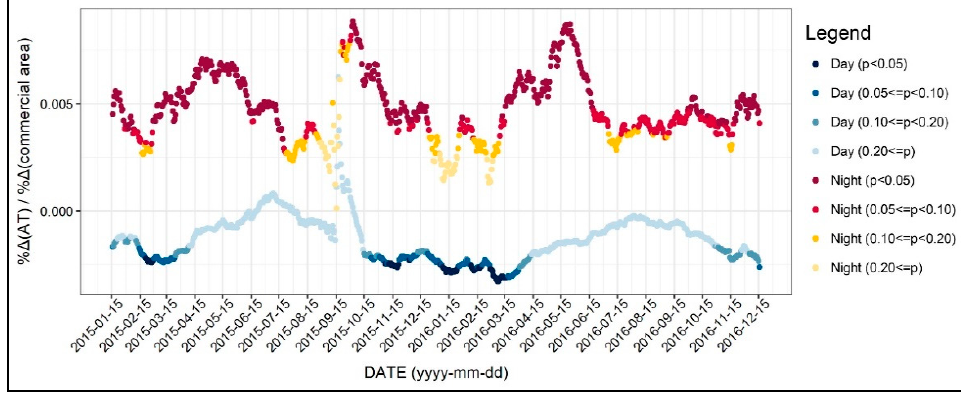
Figure 10. Changing patterns in the regression coefficients and their significances (commercial use).